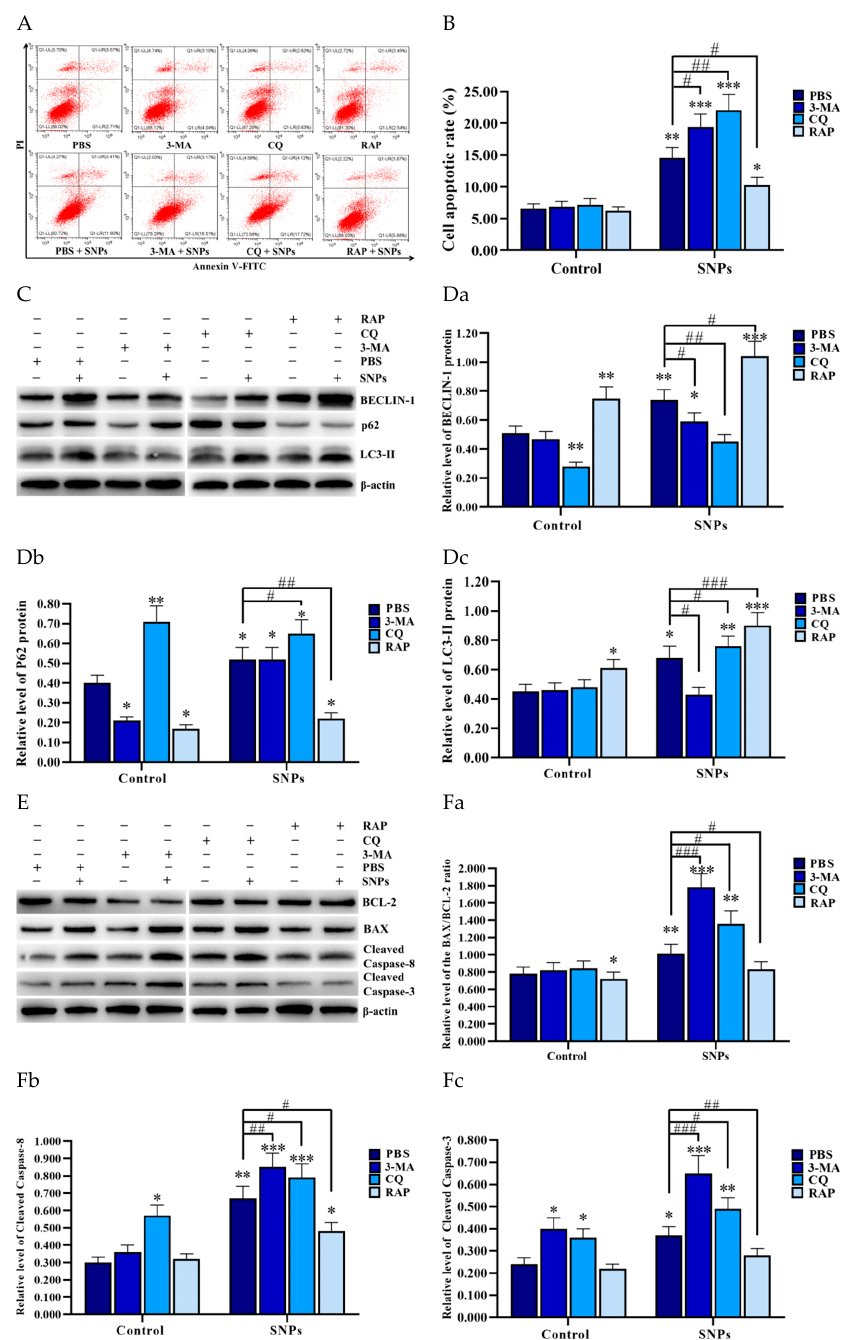
Figure 6. Effect of autophagy on SNP-induced apoptosis. ( A ) The apoptotic rate was detected by flow cytometry. The PLCs were treated with 400 µ g/mL SNPs for 24 h pretreatment with 3-MA (0.2 µ M), CQ (5 µ M), and RAP (1 µ M) for 6 h. ( B ) Bar graphs of the statistical analysis of the apoptotic rate in ( A ). ( C ) Autophagy-related proteins were detected by Western blotting. ( D ) Bar graphs of the statistical analyses of band intensity in C as the relative ratio of BECLIN-1 ( Da ), P62 ( Db ), and LC3-II ( Dc ), respectively, to β -actin. ( E ) Apoptosis-related proteins were detected by Western blotting. The PLCs were treated with 400 µ g/mL SNPs for 12 h pretreatment with 3-MA (0.2 µ M), CQ (5 µ M), and RAP (1 µ M) for 6 h. ( F ) Bar graphs of the statistical analyses of band intensity in ( E ) as the relative ratio of the BAX/BCL-2 ratio ( Fa ), cleaved caspase 8 ( Fb ), and cleaved caspase 3 ( Fc ), respectively, to β -actin. Note: * p < 0.05, ** p < 0.01, and *** p < 0.001 compared to the PBS group; # p < 0.05, ## p < 0.01, and ### p < 0.001 compared to the PBS + SNP